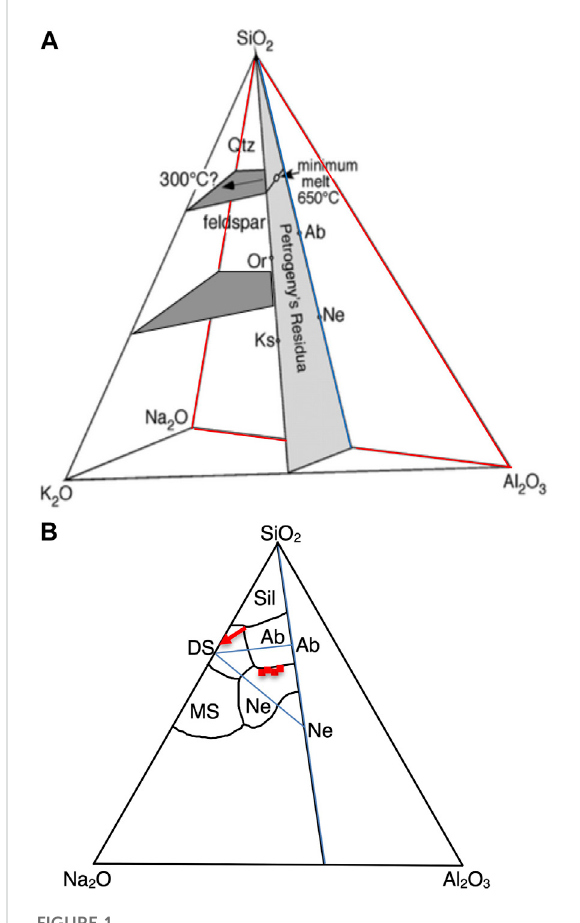
FIGURE 1 (A) Schematic phase diagram of Na 2 O-K 2 O-Al 2 O 3 -SiO 2 (+H 2 O)systemshowingthequartz-feldsparsaturatedmeltsurface (darker gray) emanating from the minimum melt point on Petrogeny ’ s residua (Lundstrom, 2016). A second plane of nepheline-feldspar saturated melt compositions (lower darker gray plane) should exist at lower silica. Red outlines location of ternaryNa 2 O-Al 2 O 3 -SiO 2 shownin (B) wherethedryNa 2 O-Al 2 O 3 - SiO 2 ternary boundaries of Schairer and Bowen (1947) have been redrawn (Sil=qtz or tridymite; Ab=albite; Ne=nepheline; MS=Na metasilicate; DS=Na disilicate). Red arrow shows continuation of Sil-Ab cotectic to Na 2 O-SiO 2 join when water is added to the system. Red squares show location of four nepheline-albite saturatedmeltsdeterminedhere;thesede fi nealineshiftedslightly to lower silica relative to the nepheline-albite cotectic of Schairer and Bowen (1947). Blue triangle bounds bulk compositions of starting